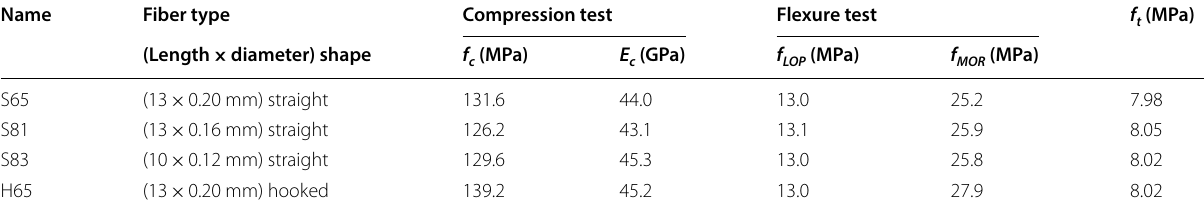
Table 4 Material properties of UHPC.